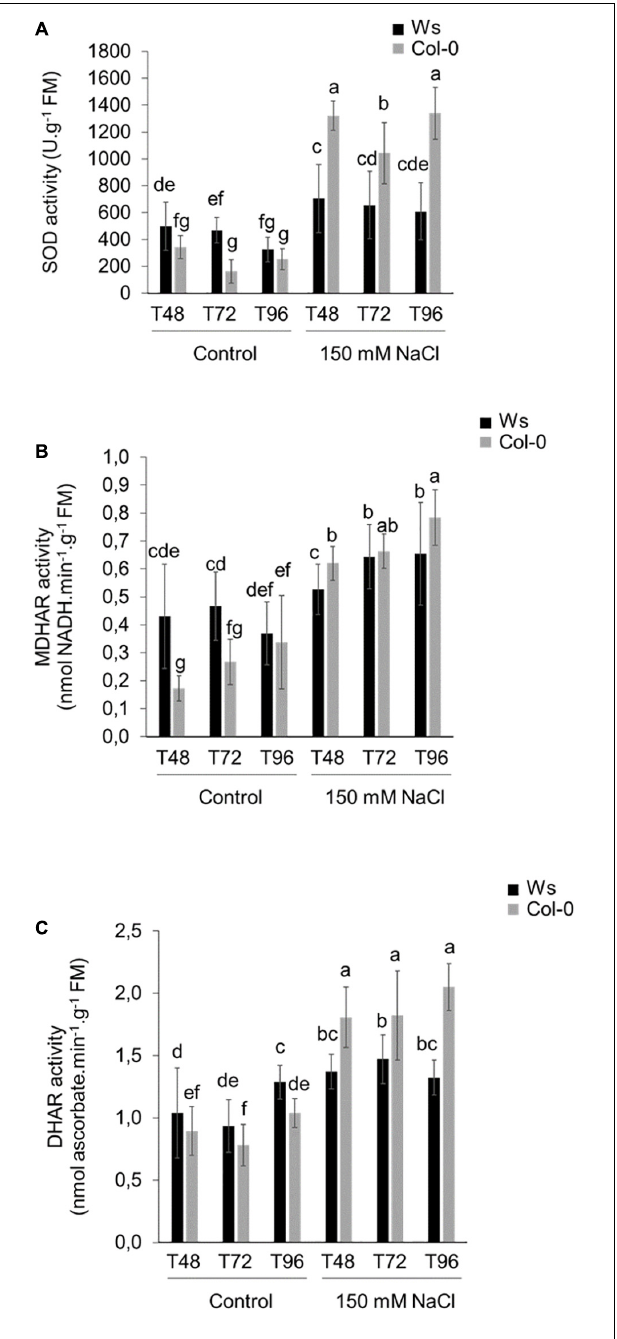
FIGURE 3 | Antioxidant enzymatic activities in 3-week-old salt-treated Ws and Col-0 shoots. (A) SOD, (B) MDHAR, and (C) DHAR enzymatic activities measured under control conditions and 150 mM NaCl at T48, T72, and T96. Data are means ± standard deviation of three biological replicates. Means followed by the same letter in the same graph are not significantly different according to Dunn